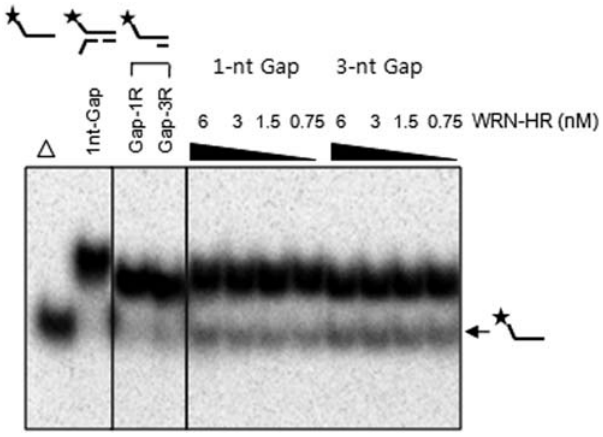
Figure 3. Radiometric DNA helicase assay using gap substrates and WRN-HR. Lanes 1–4 are control samples without WRN-HR. Lanes 5–8 contain decreasing concentration of WRN-HR from 6 nM to 0.75 nM using 1-nt gap substrate. Likewise, lanes 9–12 contain the same range of WRN-HR concentration using 3-nt gap substrate. Asterisk indicates a 5 9 - 32 P labeled strand. D indicates boiled